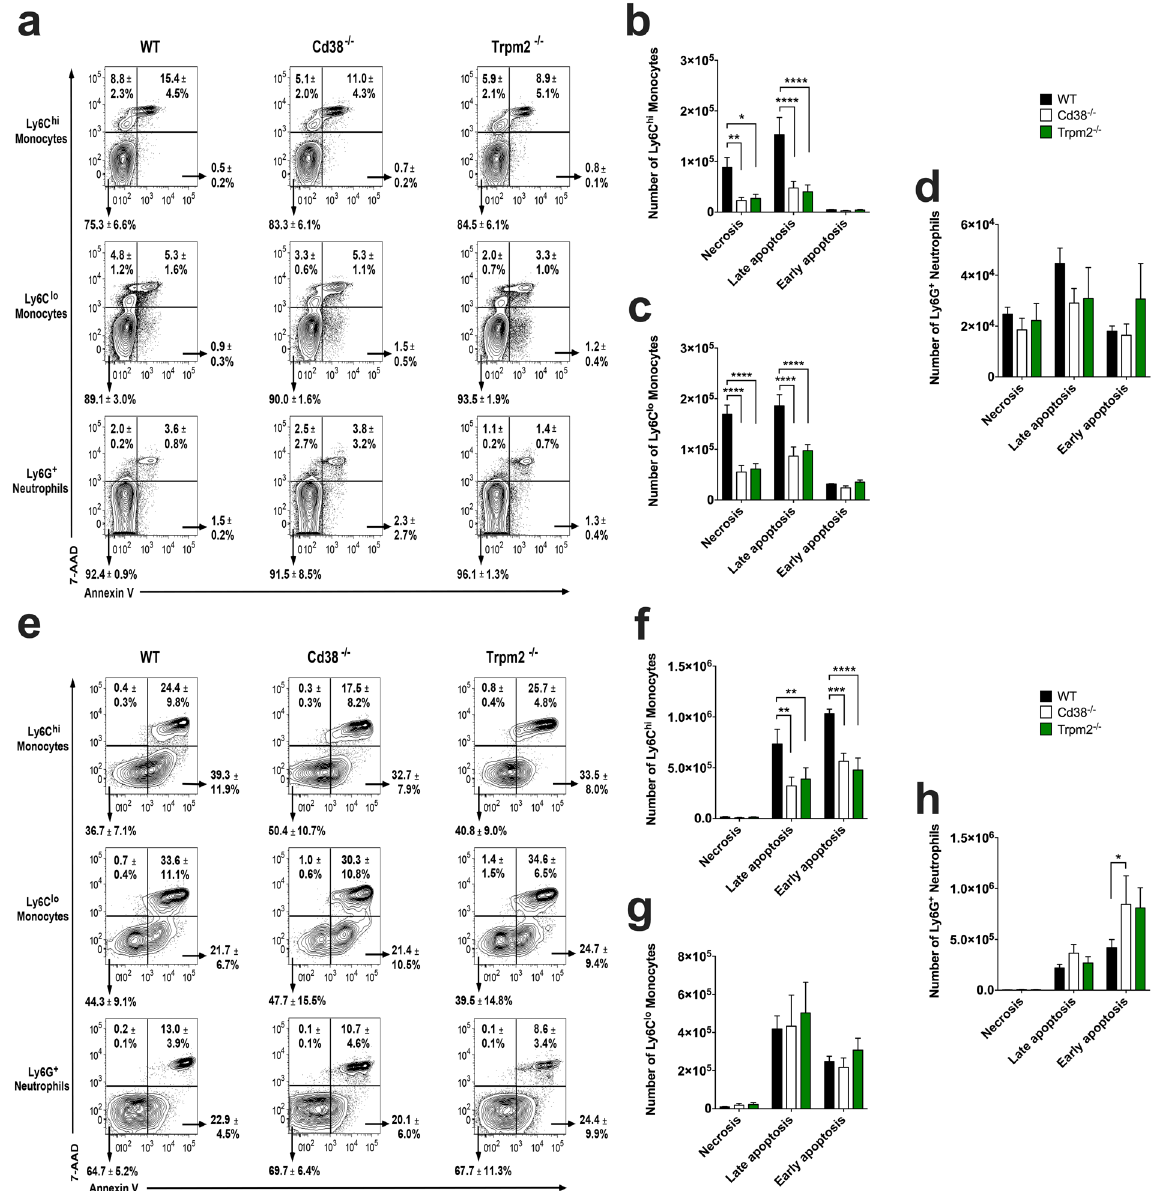
Figure 3. Defective pristane-induced apoptosis in Ly6C hi monocytes and Ly6C lo monocytes/macrophages from Cd38 − / − and Trpm2 − / − mice. ( a , e ) Flow cytometric analysis of Annexin V (AnnV) and 7-AAD staining of Ly6C hi monocytes, Ly6C lo monocytes/macrophages and Ly6G + neutrophils from 1-week pristane-treated (a) and 2-weeks pristane-treated (e) WT, Cd38 − / − and Trpm2 − / − mice. Frequencies of AnnV − 7-AAD − live cells, AnnV + 7-AAD − early apoptotic cells, AnnV + 7-AAD + end-stage apoptotic/dead cells and AnnV − 7- AAD + necrotic cells are shown as percentages of the Ly6C hi , Ly6C lo and Ly6G + parent cell populations ± SD (n = 5 mice/group). Dot plots shown are representative of 2 independent experiments. (b–d) Numbers of early apoptotic, late apoptotic and necrotic Ly6C hi monocytes (b ), Ly6C lo monocytes/macrophages (c) and Ly6G + neutrophils (d) from 1-week pristane-treated WT, Cd38 − / − , and Trmp2 − / − mice. Data are shown as the mean ± SD (n = 5 mice/group). (f–h) Numbers of early apoptotic, late apoptotic and necrotic Ly6C hi monocytes (f) , Ly6C lo monocytes/macrophages (g) and Ly6G + neutrophils (h) from 2-weeks pristane-treated WT, Cd38 − / − , and Trmp2 − / − mice. Data are shown as the mean ± SD (n = 7 mice/group). * P < 0.05 ** P < 0.01 *** P < 0.001 **** P < 0.0001 by 2-way ANOVA with the Dunnett’s multiple comparisons